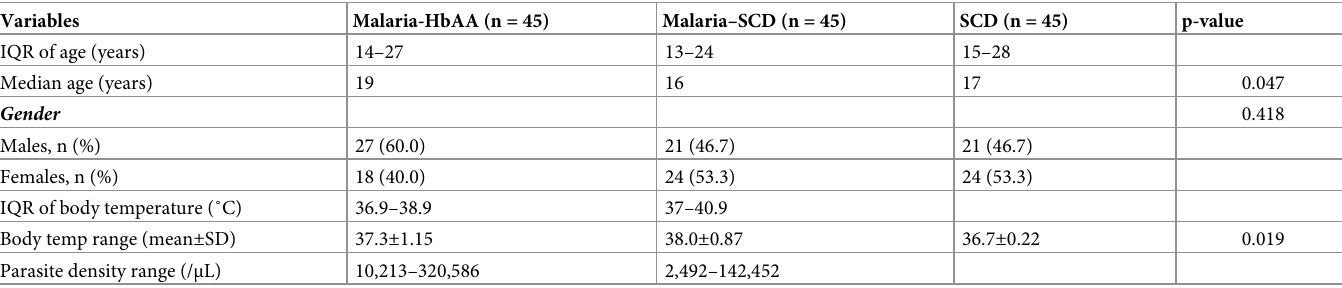
Table 2. The 8-iso-PGF2 α levels were significantly different among the age ranges, gender, and various ranges of parasite density across the three cohorts. Additionally, it was observed that 8-iso-PGF2 α levels were numerically higher in the 10–20-year age range than the 20–29-year group, irrespective of the cohort. Furthermore, in the three cohorts, 8-iso-PGF2 α levels were higher in males than in females, whereas parasite densities increased with 8-iso-PGF2 α levels in the malaria parasite-infected cohorts. However, the percentage increases in the 8-iso- PGF2 α levels were higher in malaria-SCD cohort than the malaria cohort (49.8% vs. 29%) even though the geometric mean of the parasite density was higher in the malaria cohort than the malaria-SCD cohort. In spite of the above observation, the 8-iso-PGF2 α levels in malaria- SCD cohort were significantly higher in all study variables compared to the other groups. Table 1. Demographic, temperature, and parasitemia of the patients.